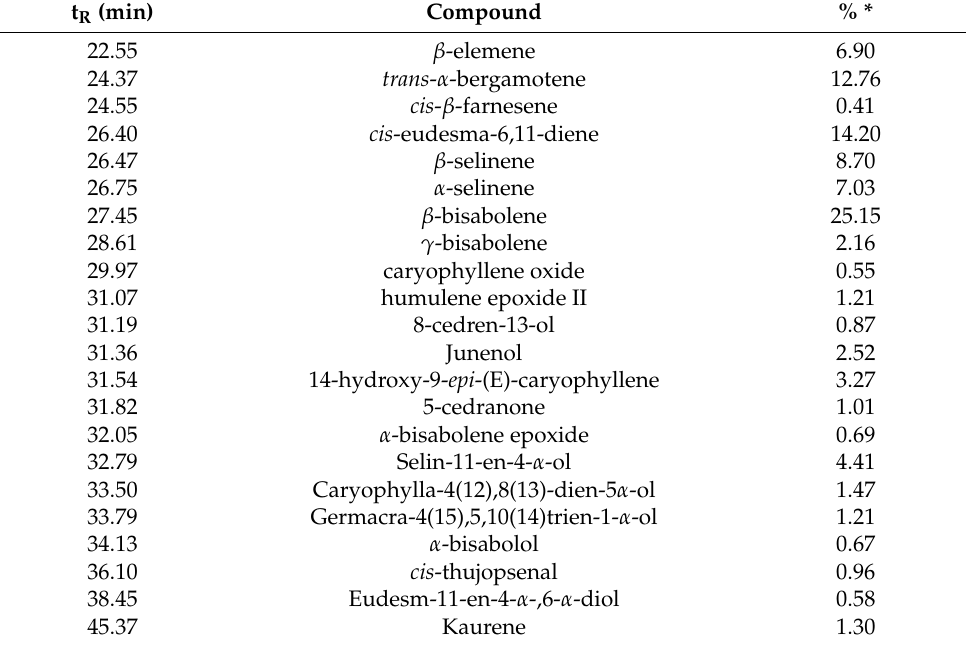
Table 1. Qualitative and quantitative composition of volatile compounds from Copaifera reticulata oleoresin by